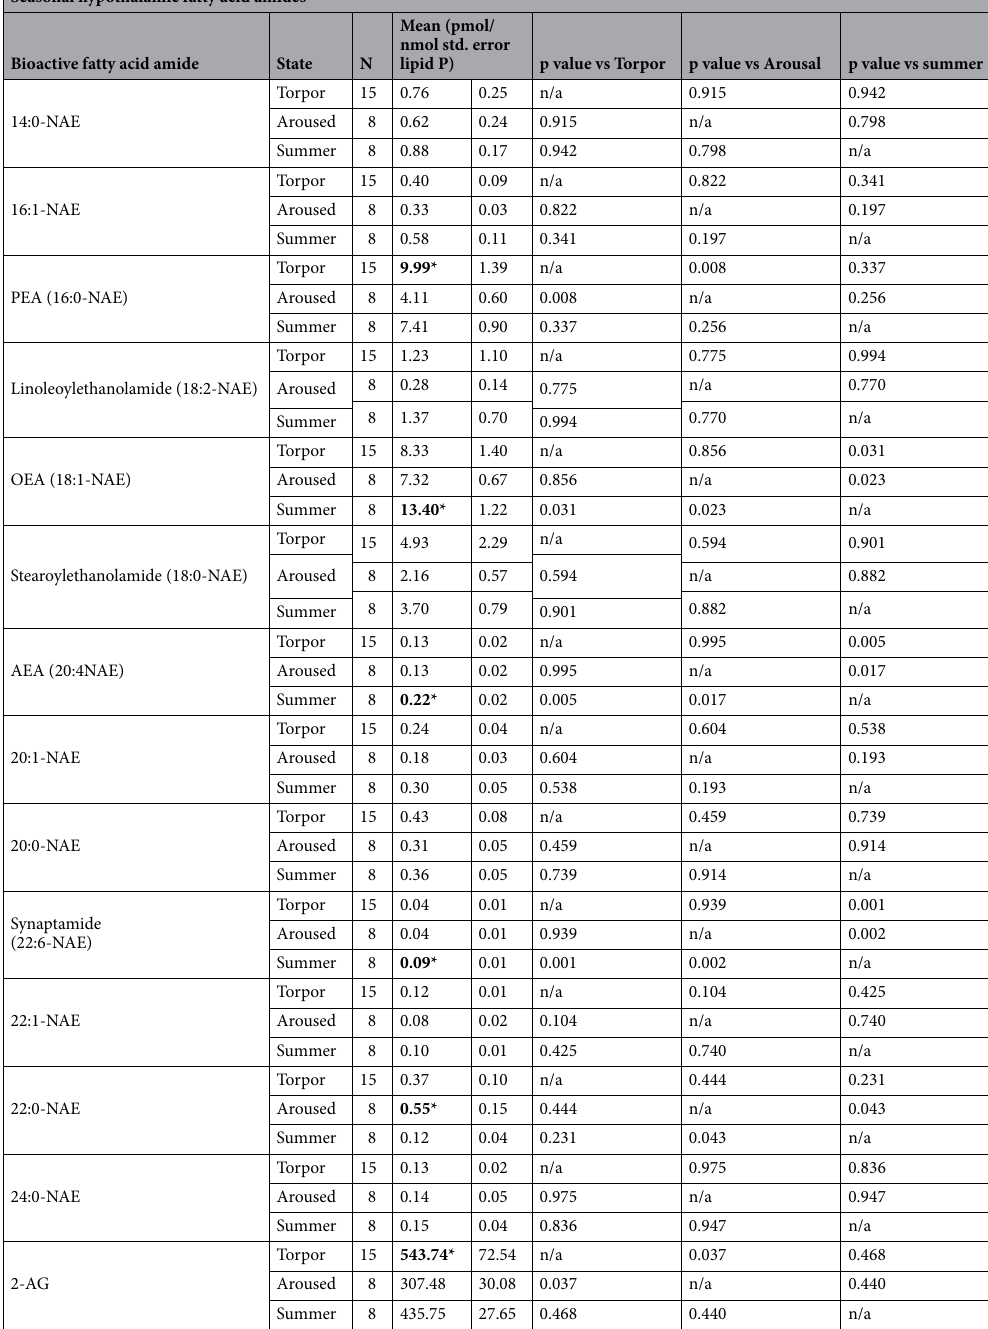
Table 2. Seasonal changes in hypothalamic endocannabinoids and NAEs. Synaptamide, AEA and OAE decrease during the hibernation season (torpor and arousal vs. summer) (post hoc Tukey following ANOVA, p < 0.05, n = 8–15). PEA and 2-AG are both higher in torpor than arousal (post hoc Tukey following ANOVA, p < 0.05, n = 8–15). SRC summer measurements were compared to torpor and IBA. Torpor and IBA measurements combined Balanced Diet and Standard Rodent